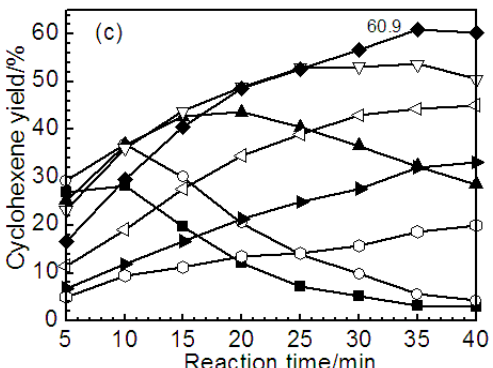
Figure 6. Catalytic activity towards selective hydrogenation of benzene over Ru-Zn/m-ZrO 2 catalysts with different Zn content (m cat = 1.2 g, m ZnSO4 = 50.0 g, v H2O = 280 cm 3 , v benzene = 140 cm 3 , T = 423 K, p H2 = 5.0 MPa). ( a ) Benzene conversion as function of reaction time; ( b ) Cyclohexene selectivity as function of benzene conversion; ( c ) Cyclohexene yield as function of reaction time.